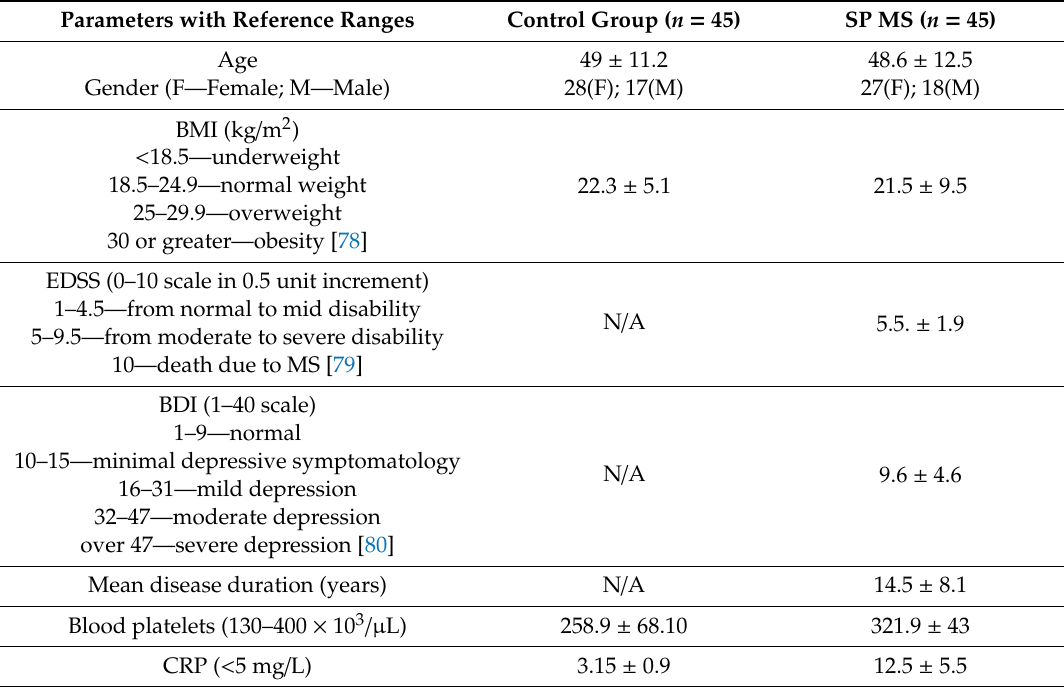
Table 2. The Clinical characteristics of SP MS patients and control group (with reference range); all results are expressed as mean ±